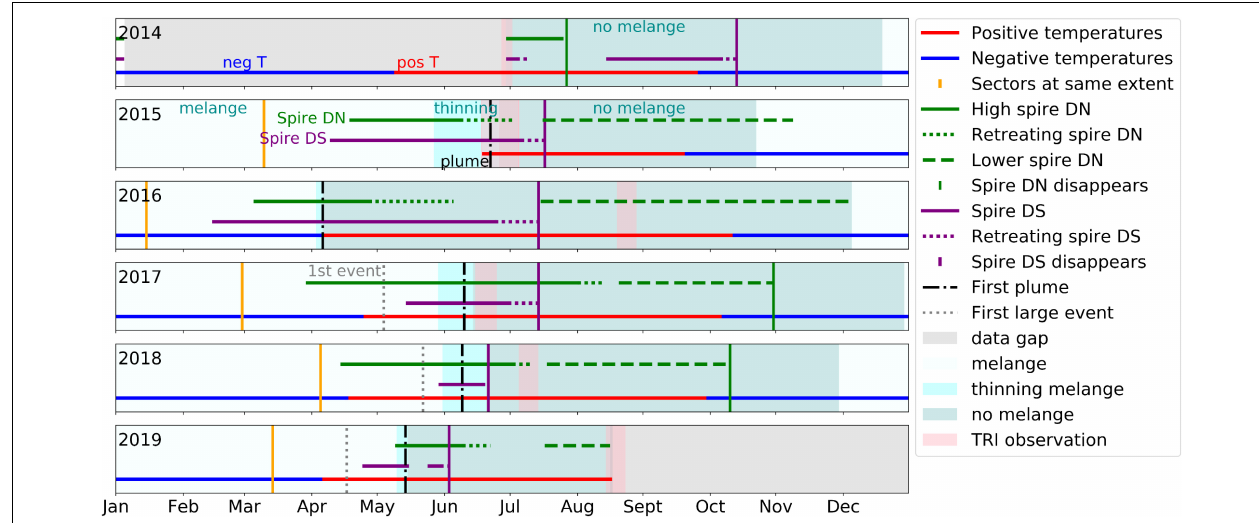
FIGURE 9 | Calving front evolution throughout the year for 2014–2019 analyzed with hTLC and dTLC images. Important events and states in the calving front evolution are indicated, as well as periods of melting or freezing conditions, mélange cover and TRI field campaigns. Two spires form in the deep sector D, one in the northern sector D (DN) and one in the southern sector D (DS).